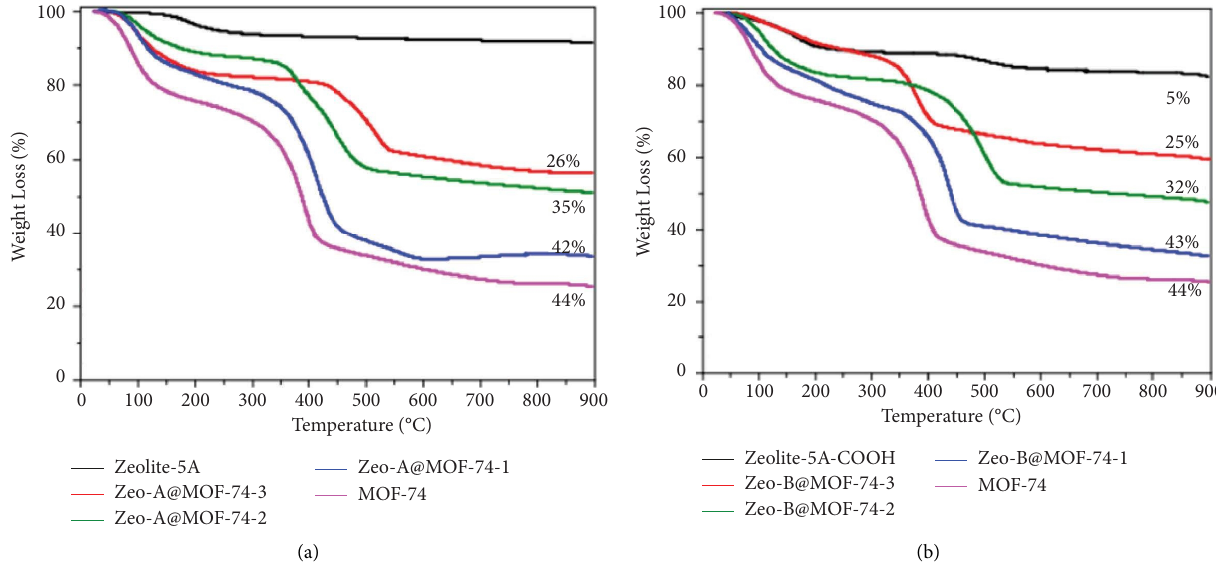
Figure 21: Termogravimetric curves for (a) zeolite-5A and (b) zeolite-5A-COOH based composites adopted from [41]. Table 2: Elemental composition (atomic %) of the composites determined by EDX analysis [41].